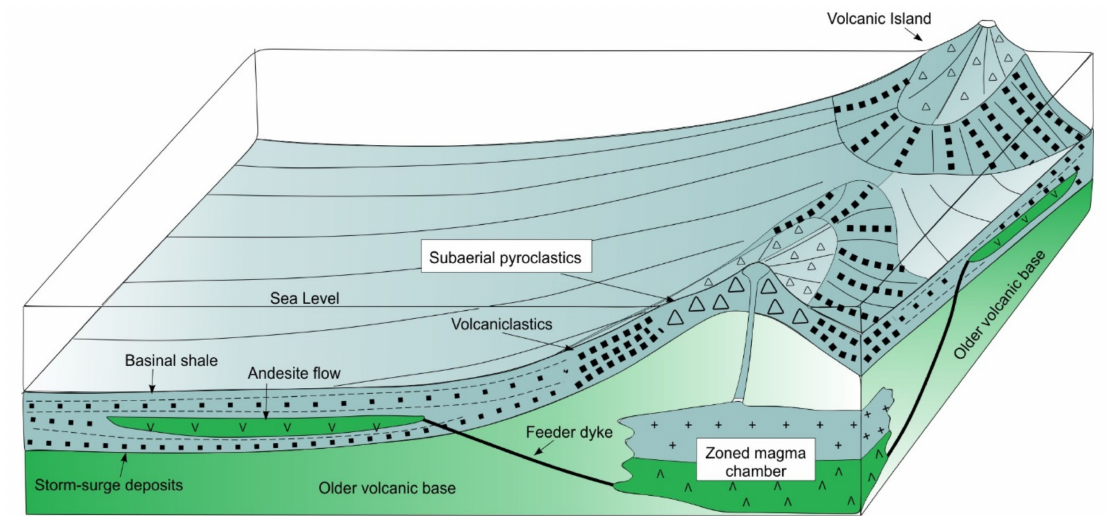
Figure 10. Paleogeographic reconstruction of felsic centers resting on an older mafic volcanic base (modified from [133]), which can be applied for the Cuiab á (and Lamego) gold